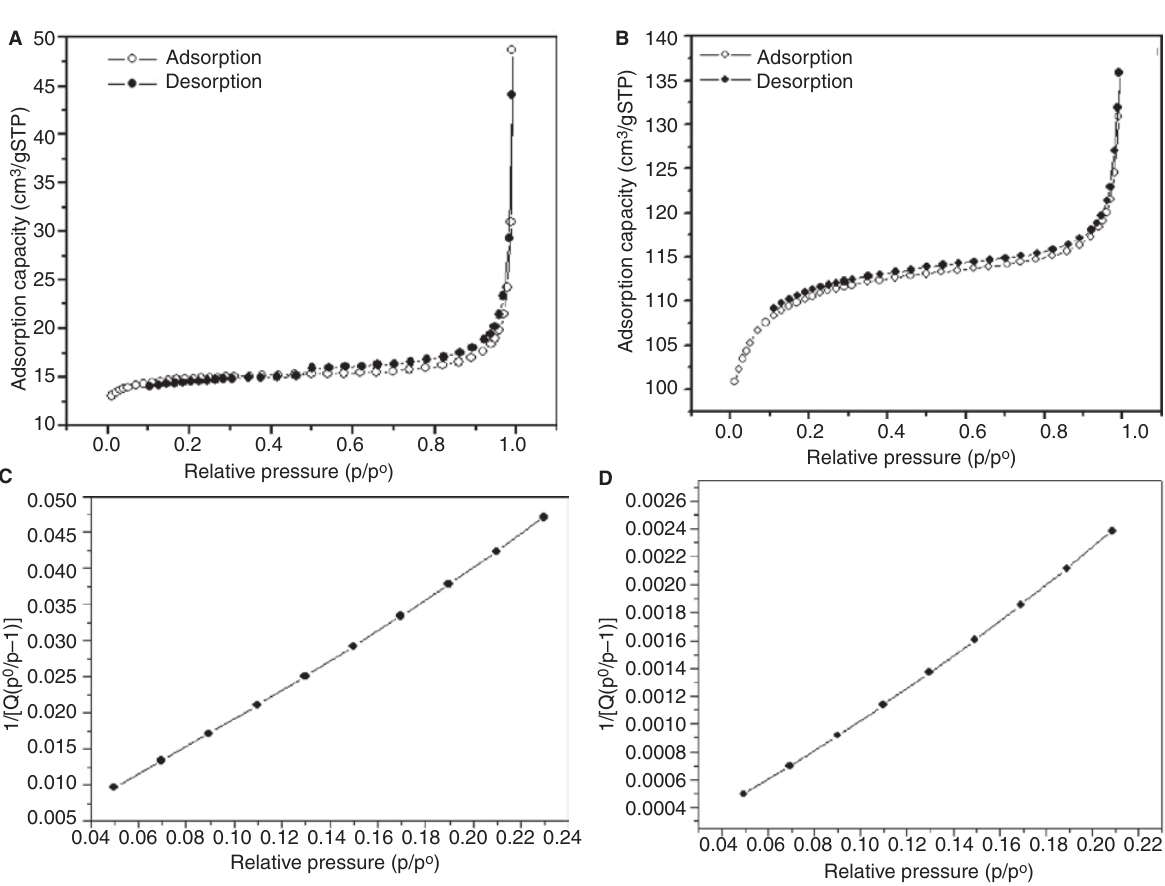
Figure 10: The BET adsorption isotherm curves (A, B) and the BET curves (C, D) of Cu-BTC, formed from Cu and benzene-1,3,5-tricarboxylic acid, (A, C) and Cu-BTC immersed in water during 20 min (B, D) synthesized by the applied potential